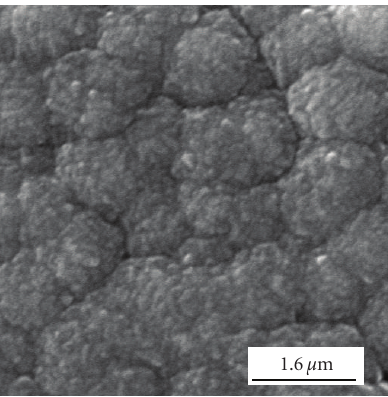
Figure 8: SEM image of BDND film grown on a silicon substrate.